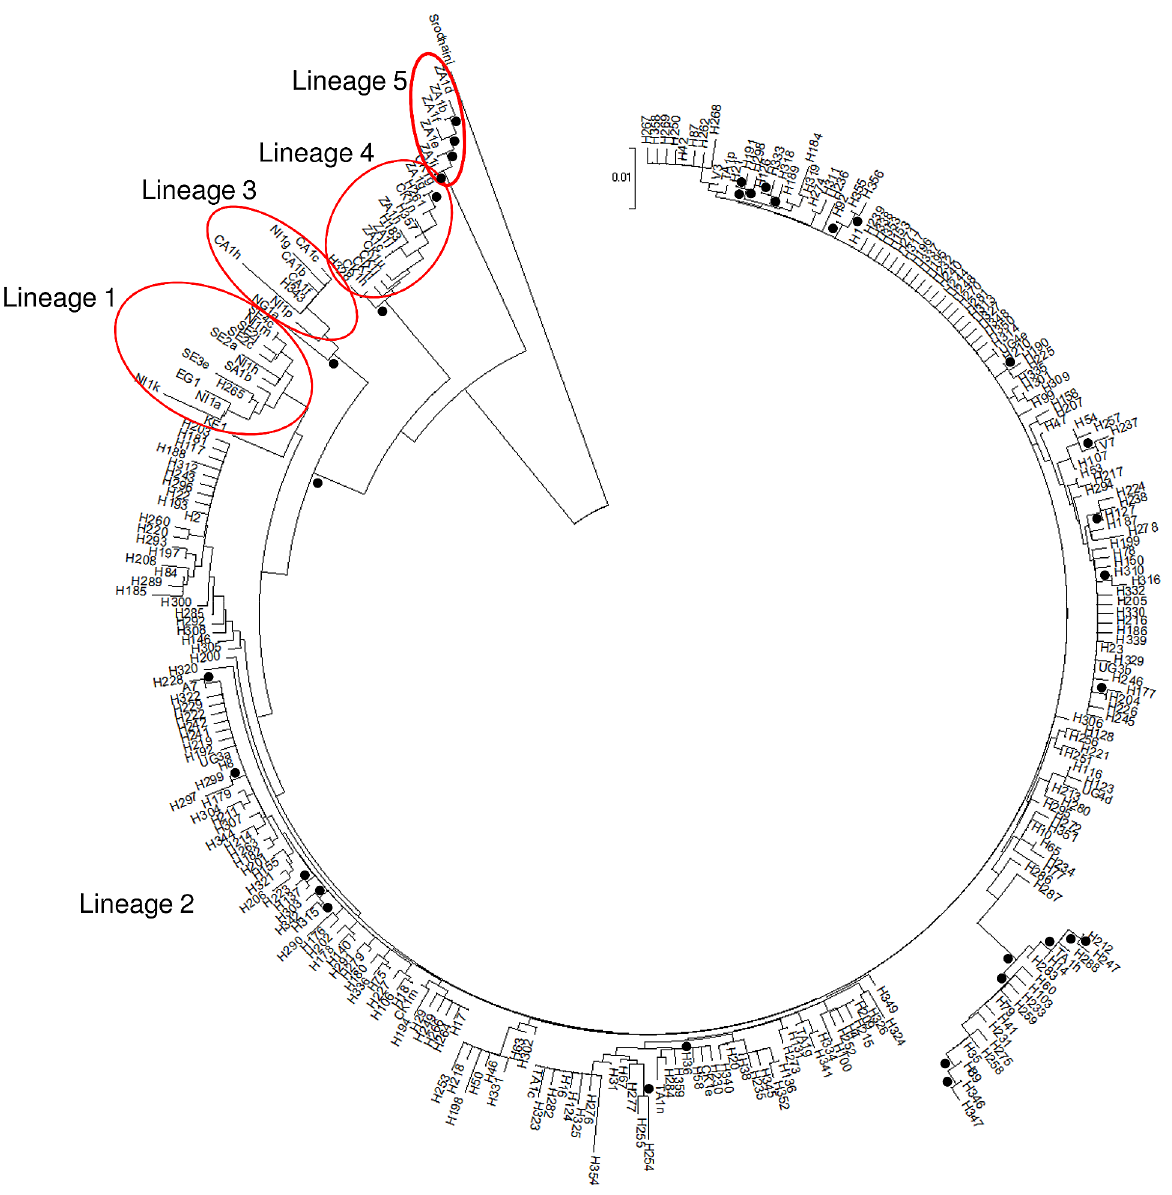
Figure 3. A neighbour joining tree based on Kimura-2-parameters representing phylogenetic relationships between haplotypes identified during the baseline surveys and selected haplotypes from across the globe. Black dots represent branches for which bootstrap support was over 75% (1000 replicates). Most haplotypes fall into lineage 2 as identified by Webster et al. [20]. Haplotypes falling into lineages 1, 3, 4 and 5 are indicated using red oval outlines.